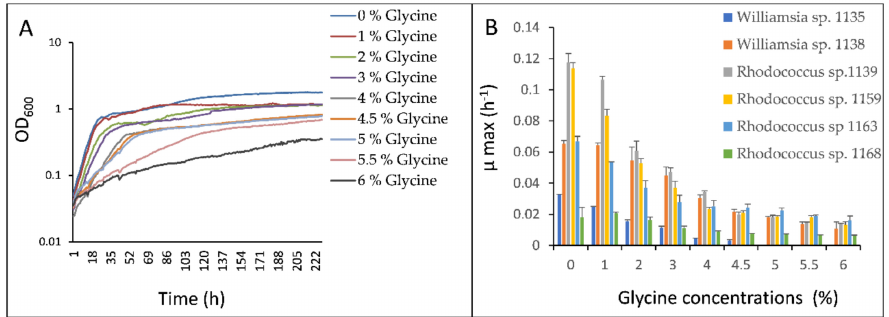
Figure 1. Impact of glycine on growth of six sub-Antarctic strains. ( A ) An example of growth kinetics of strain Williamsia sp. 1138 in MSM-F broth supplemented with different concentrations of glycine; ( B ) means and standard deviations of maximum specific growth rates ( µ max ) for six strains cultured in MSM–glycine